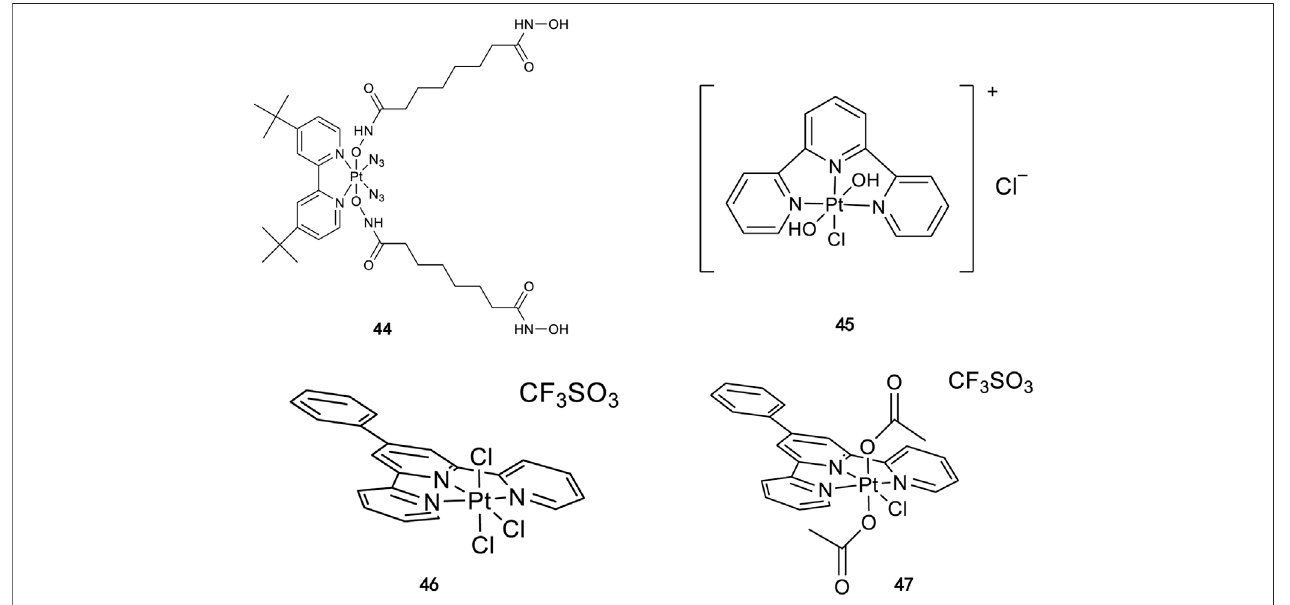
FIGURE 3 | Chemical structure of complexes 44 – 47 [adapted from Kasparkova et al. (2015); Gabano et al. (2017); Canil et al.